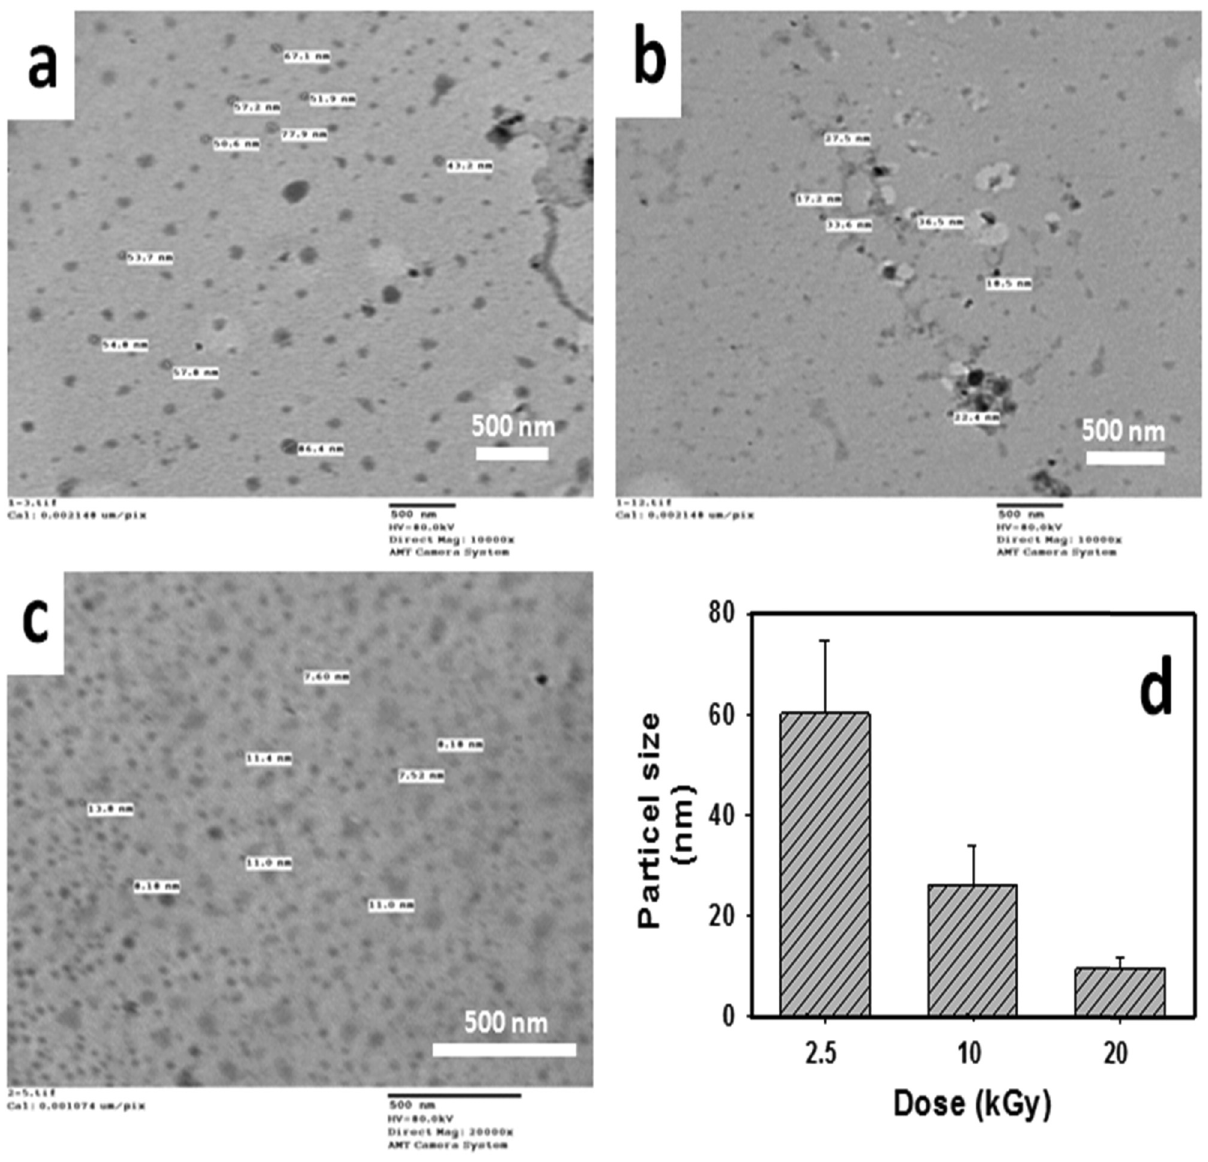
Figure 2: TEM photomicrographs of ( PVP:CMC ) /CA/G/ZnO nano fi lms at: ( a ) 2.5 kGy, ( b ) 10 kGy, ( c ) 20 kGy, and ( d ) the e ff ect of dose on ZnO - NP